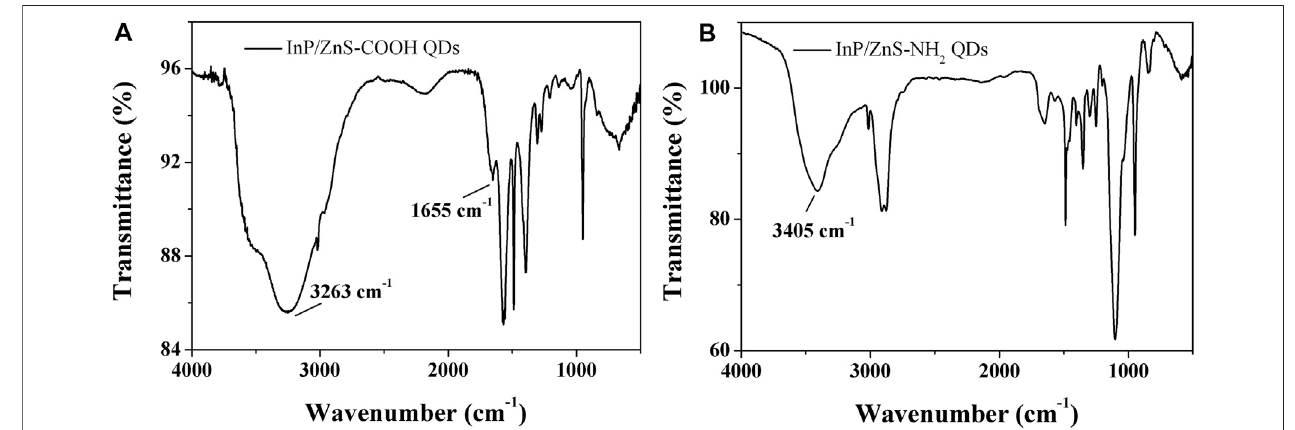
FIGURE 1 | Infrared spectrum of InP/ZnS QDs coated with carboxyl (A) and amino (B) groups.